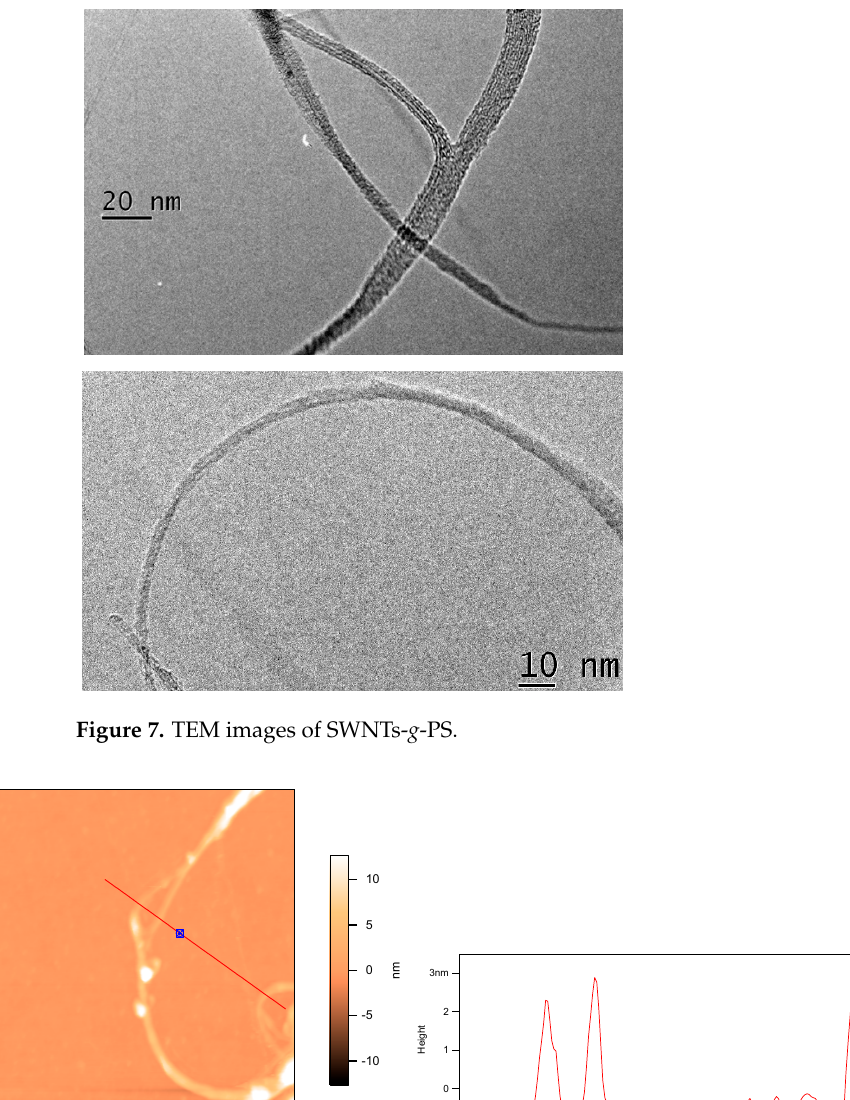
9 of 13 Figure 6. Raman spectra of pristine SWNTs, and SWNTs- g -PS 4.5K.